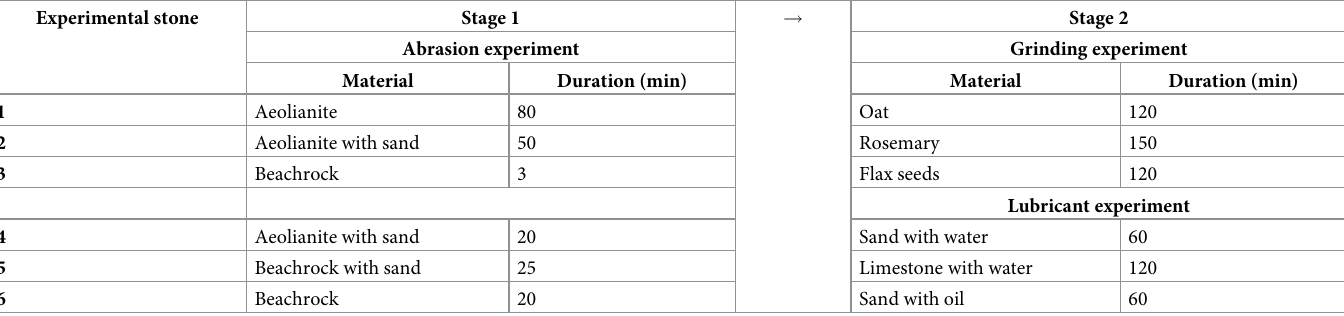
Table 2. The experimental program showing the sequence of operations and the materials used for abrasion, grinding, and lubrication. Experimental